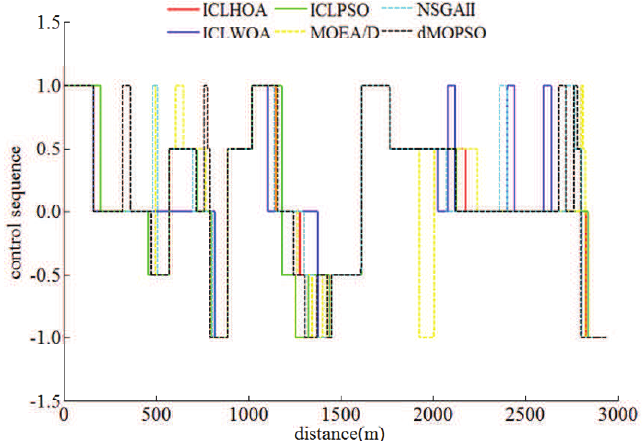
Figure 20. The control sequence distance curve obtained by different algorithms in